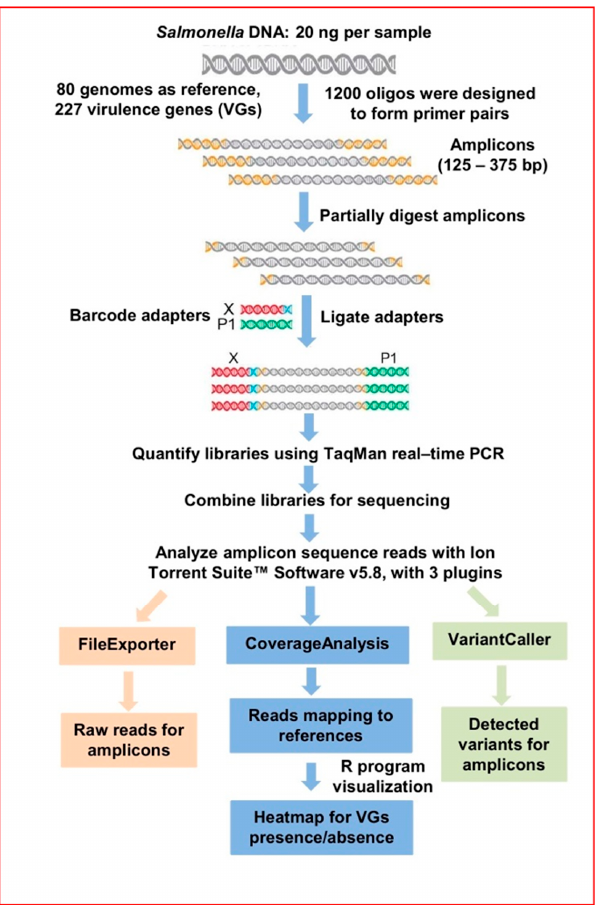
Figure 1. Workflow for the adaptation of AmpliSeq technology to develop and construct the Am ‐ pliSeq Salm_227VG panel. VGs: virulence genes.